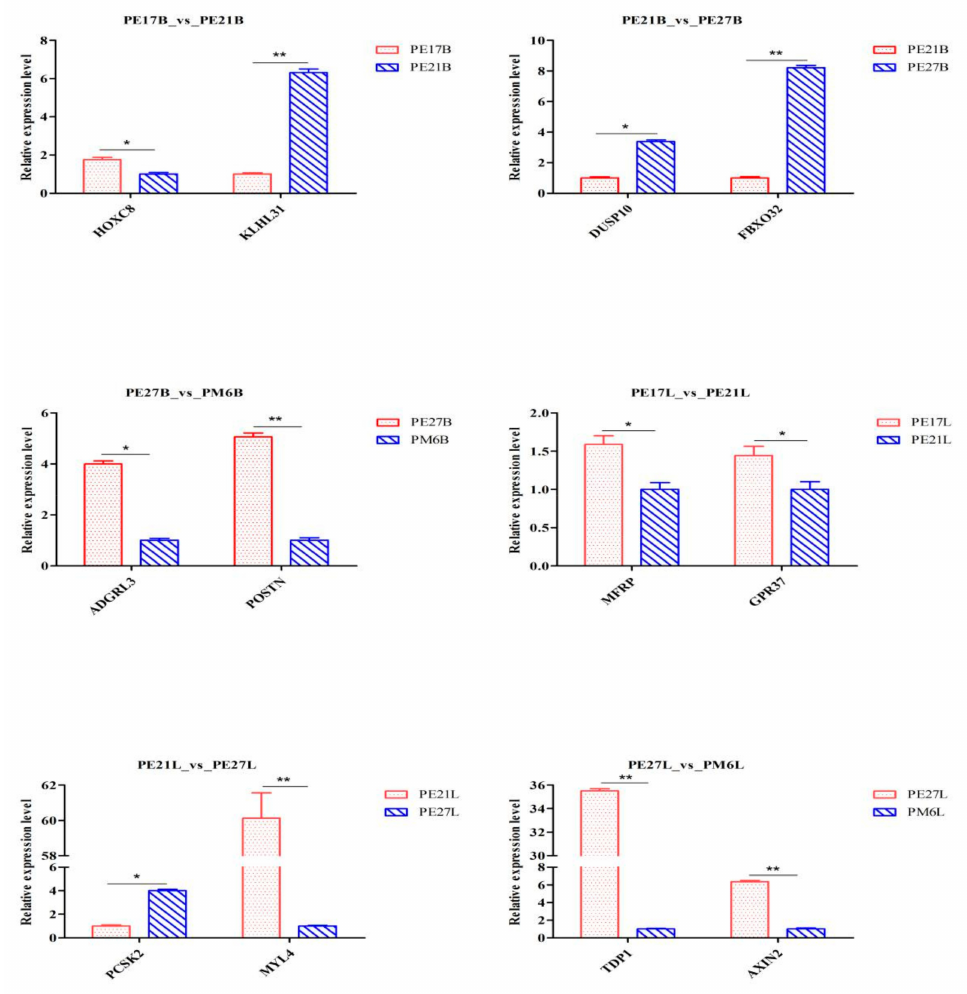
Figure 7. qPCR verification of DEGs. “*” was considered significant difference ( p < 0.05); “**” was considered highly significant difference ( p <